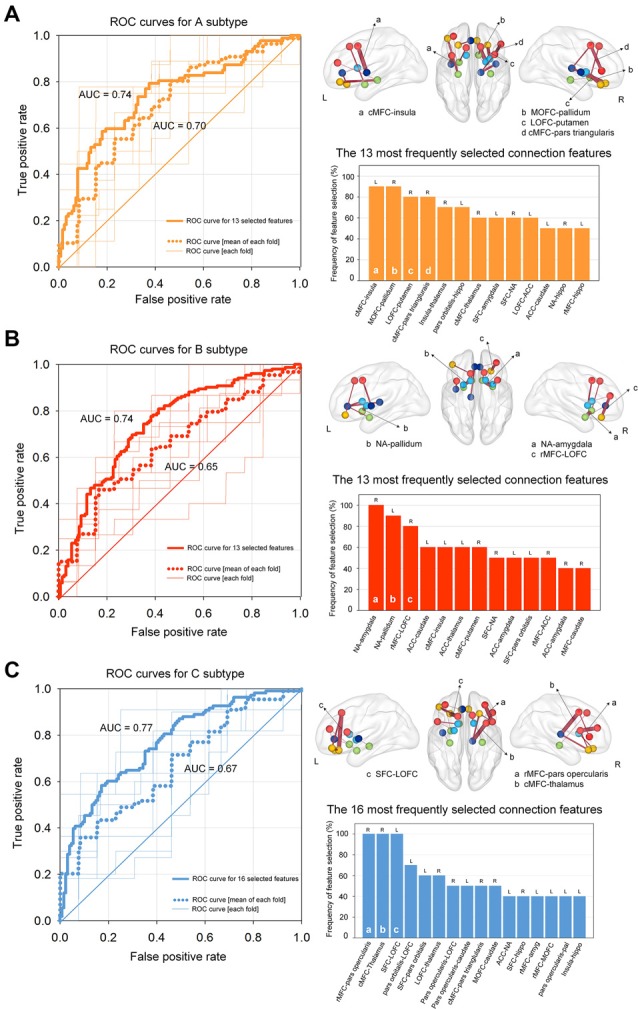
ROC curves for classifying each subtype using regularized logistic regression based on structural connectivity data of the addiction circuitry: (A) neutral vs. A subtypes; (B) neutral vs. B subtypes; (C) neutral vs. C subtypes. Thin lines within each ROC graph indicate the ROC curve from each outer fold test set and dotted lines were obtained by averaging ROC curves of outer 10-fold test sets. Thick lines of the ROC graphs represent the ROC curve from the model based on the most frequently selected connection features for each model. The location and frequency of the most frequently selected structural connections in all successive cross-validation trials were presented in grass brains and bar graphs, respectively. The top 30% of the most frequently selected connection features are presented. ROC, receiver operating characteristic; AUC, area under the curve; cMFC, caudal medial frontal cortex; MOFC, medial orbitofrontal cortex; LOFC, lateral orbitofrontal cortex; NA, nucleus accumbens; ACC, anterior cingulate cortex; SFC, superior frontal cortex; rMFC, rostral medial frontal cortex; L, left; R, right.